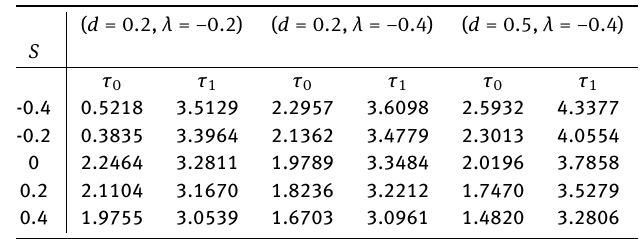
Table 3: skin friction τ at the heated plate y = 0 and cold plate y = 1 , for different values of S , d and λ where Br = 0.2 , ε = −0.3 , Gre = 10 and q =